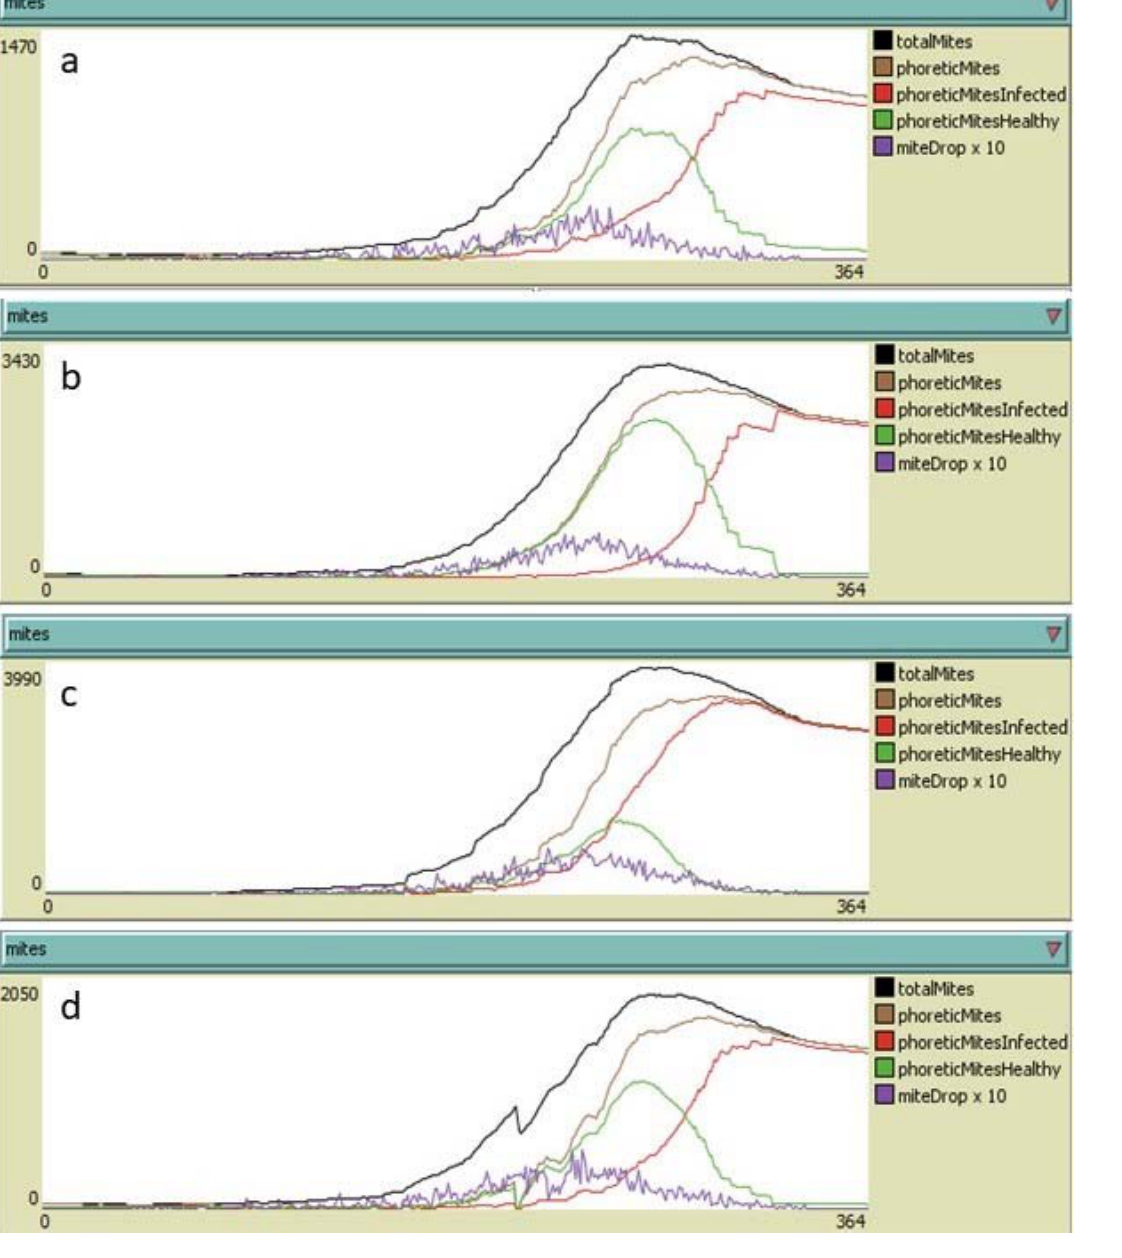
Figure 8. Yearly development of Varroa destructor infestation in colonies not subjected to hyperthermia under different hypotheses of re-infestation: ( a ) no re-infestation; ( b ) 30 mites per month from June to September (120 mites in total); ( c ) 150 mites per month from June to September (600 mites in total); ( d ) 30 mites per month from June to September (120 mites in total) with a dripped oxalic acid treatment at the end of July with 95% efficacy on phoretic mites and efficacy duration of 1 day. Adult mites alive on 31 December: ( a ) 0; ( b ) 2283; ( c ) 2821; ( d ) 1422.